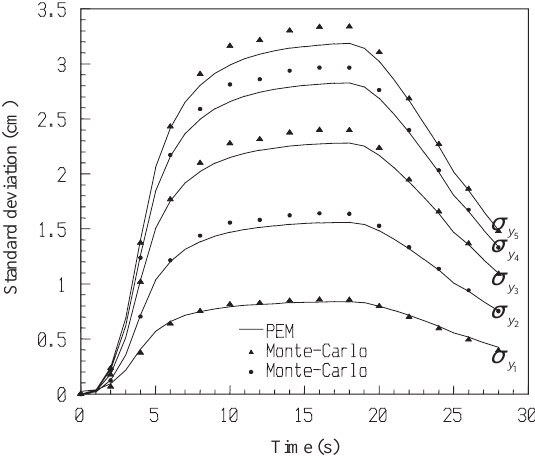
Fig. 5. Displacement standard deviations for a 5 DOF system due to seismic Kanai-Tajimi